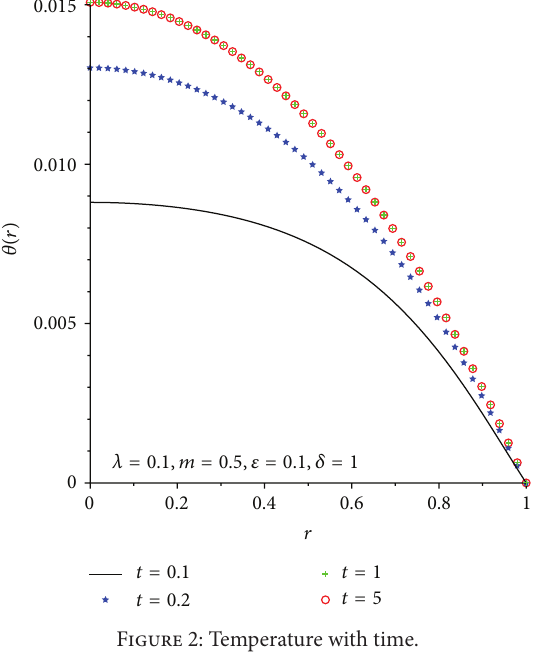
Figure 2: Temperature with time.